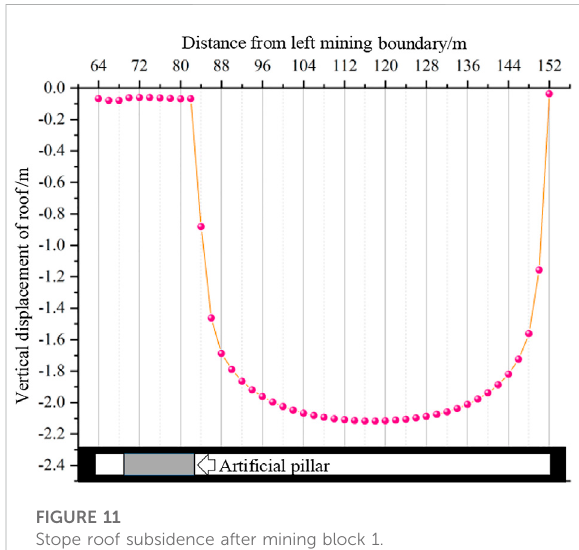
FIGURE 11 Stope roof subsidence after mining block